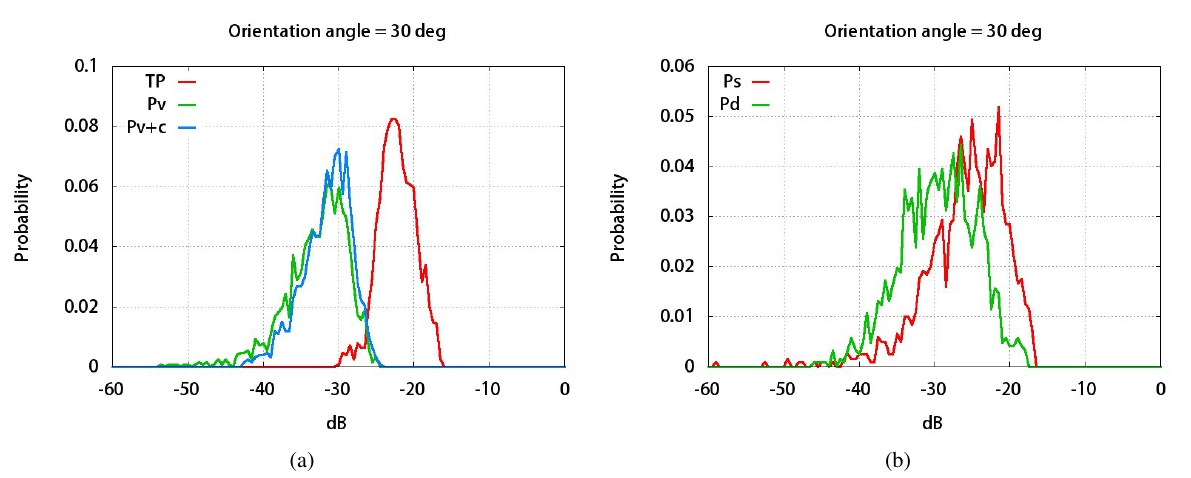
Figure 7. Histograms of scatterings when the orientation angle of the concrete blocks was set to 30 ◦ . (a) TP , P v , and P v + c ,